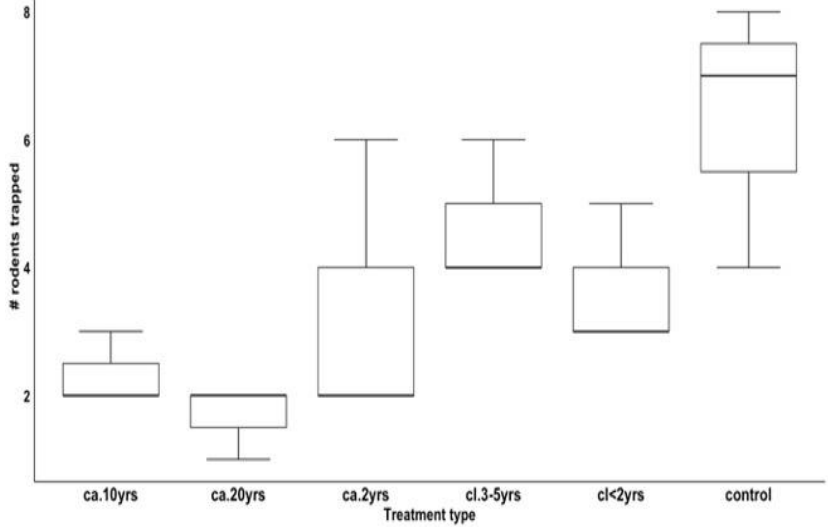
Figure 7. Counts of rodents trapped by treatment type.